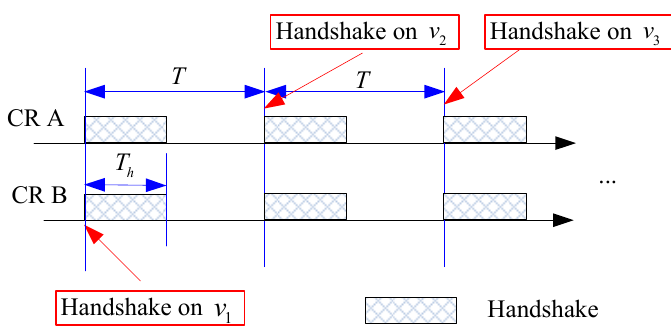
Figure 1. Handshake process for spectrum